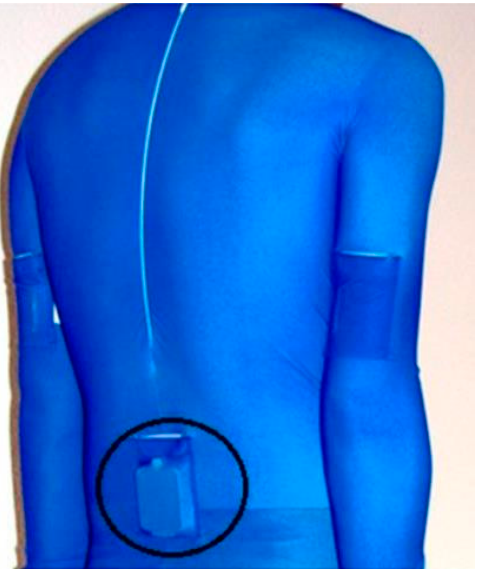
Figure 19. A modified swim suit design allows for accurate positioning of the sensor device but may result in unwanted sensor movement. Reproduced with permissions from Dadashi, Millet and Aminian [97].